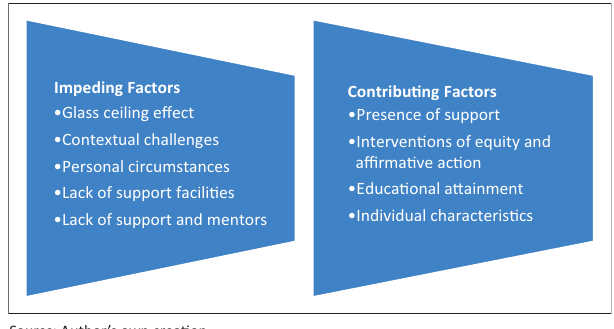
FIGURE 1: Factors contributing to and impending career success. TABLE 4: Summary of factors perceived to contribute to career success.